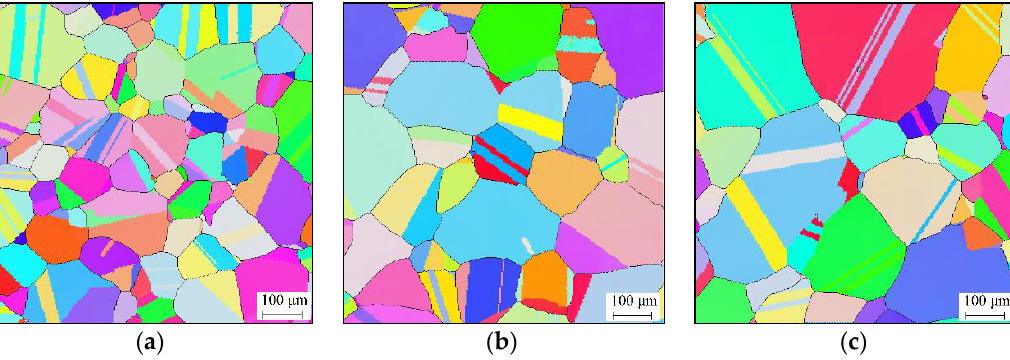
Figure 3. Grain structure under holding time of 540 s and holding temperature of ( a ) 1413 K, ( b ) 1443 K, and ( c ) 1473 K. Figure 4 illustrates the measured grain sizes at different holding times and holding